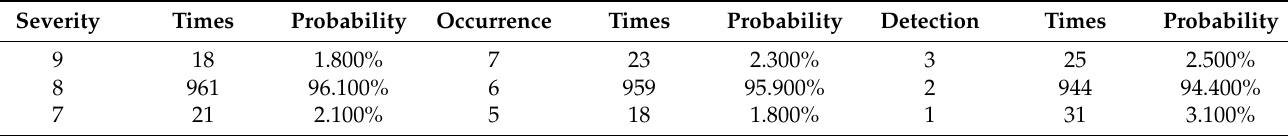
Table 3. Case 1: Probability and times of S, O, and D .